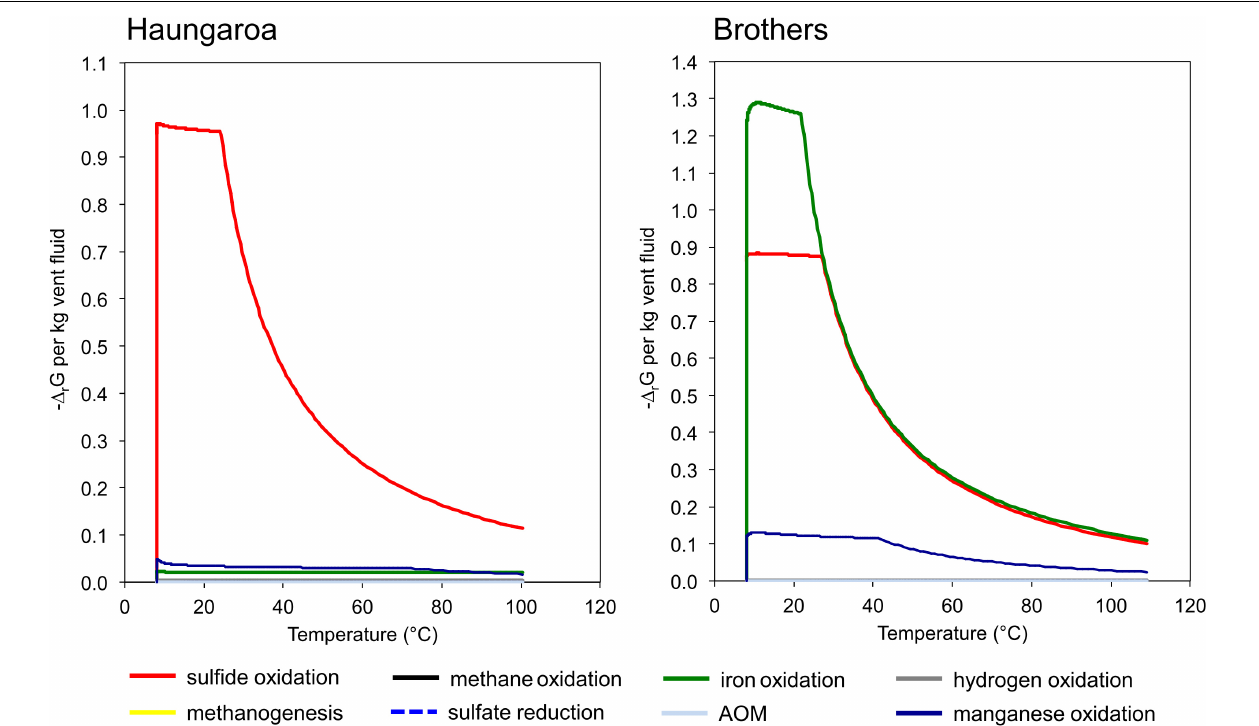
FIGURE 2 | Quantities of Gibbs energy of varied catabolic reactions at Haungaroa and at Brothers NW caldera wall. Note that sulfide oxidation is predicted to constitute the dominant energy source at Haungaroa, whereas the oxidation of iron and also of sulfide dominate the potential catabolic energy at Brothers. See Amend et al. (2011) for computational